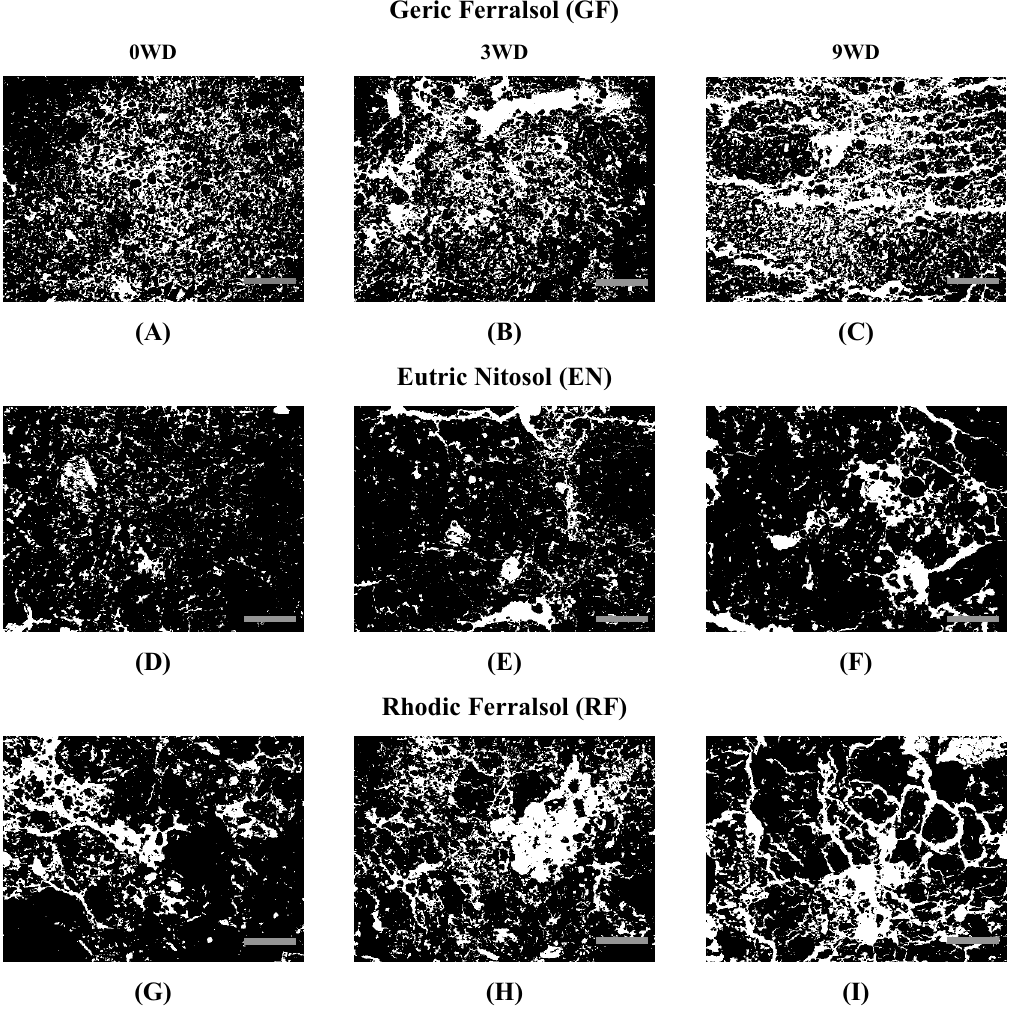
Fig. 5 – Binary images (pores appear in white and the soil matrix in black) representing the variations on the soil pore system (SPS) of damaged samples with repetitions of wetting and drying (W-D) cycles. Lines at the right corner of the images represent the scale ( 1000 μ m )